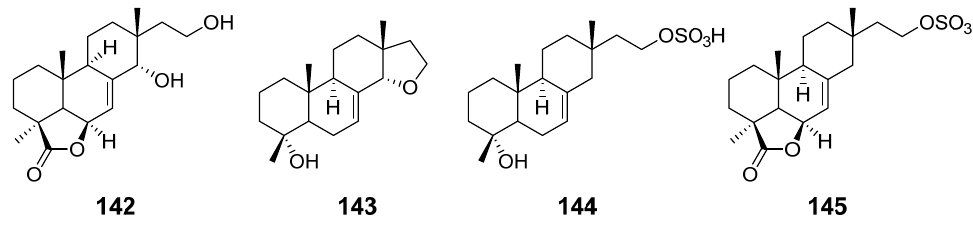
Figure 13. Structures of compounds 142 – 145 .